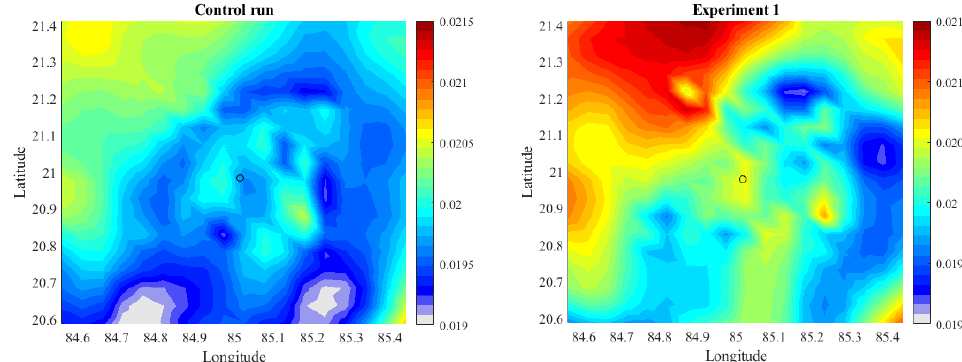
Figure 3. Water vapour mixing ratio comparisons on 16 August 2008 for WDM6 microphysics scheme at near-surface level.